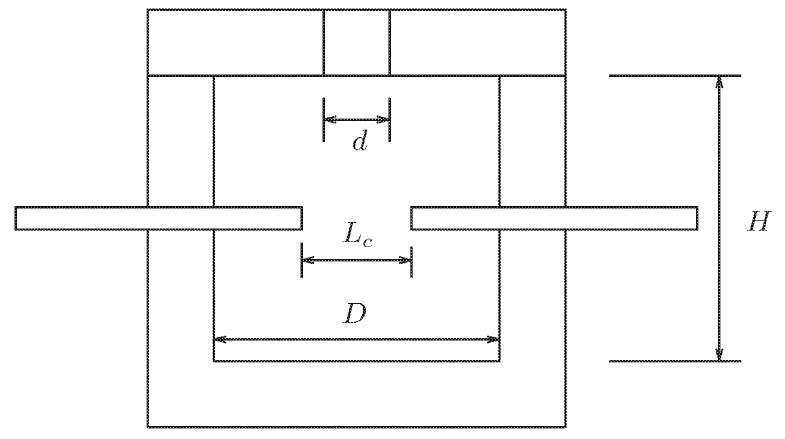
Figure 7. Sectional view of two-electrode SparkJet.